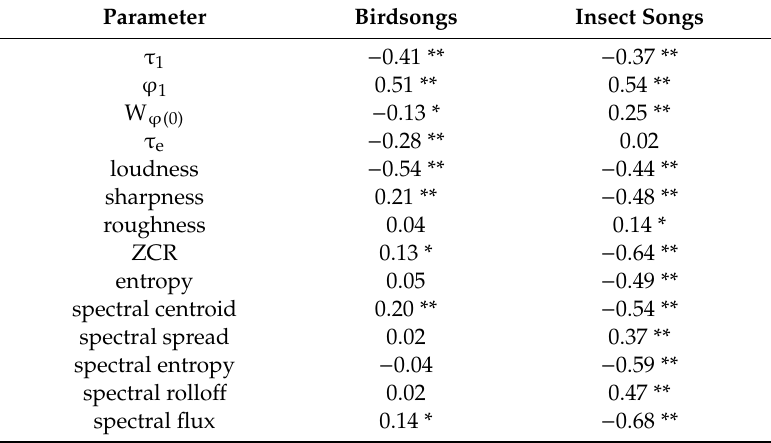
Table 3. Correlation coefficients between each physical parameter and subjective preference for birdsongs and insect songs. Asterisks indicate the level of significance, i.e., ** p < 0.01, * p < 0.05. Parameter Birdsongs